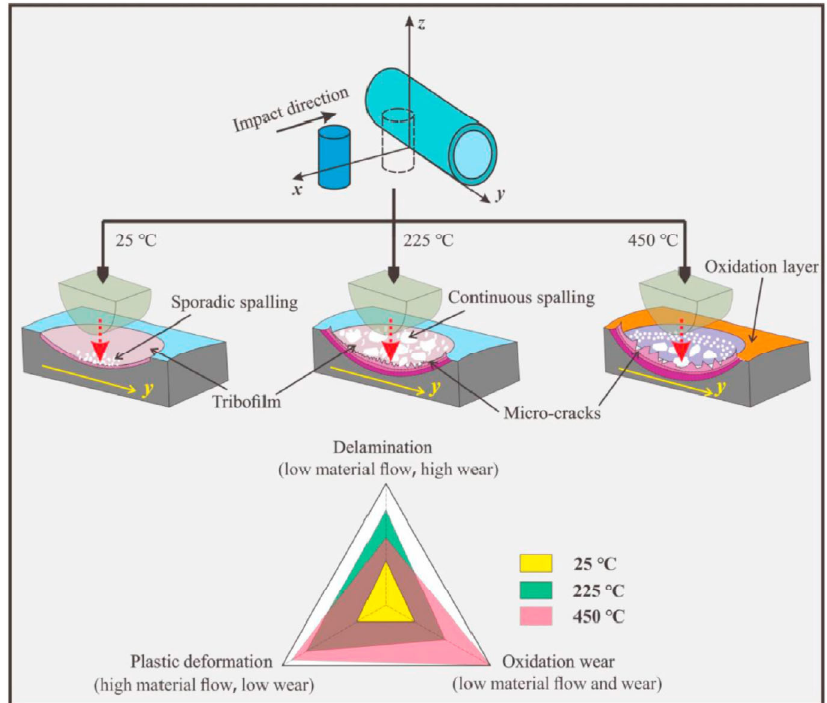
Fig. 44 Schematic of mechanisms of impact wear [799]. Reproduced with permission from Ref. [799], © Elsevier B.V.,